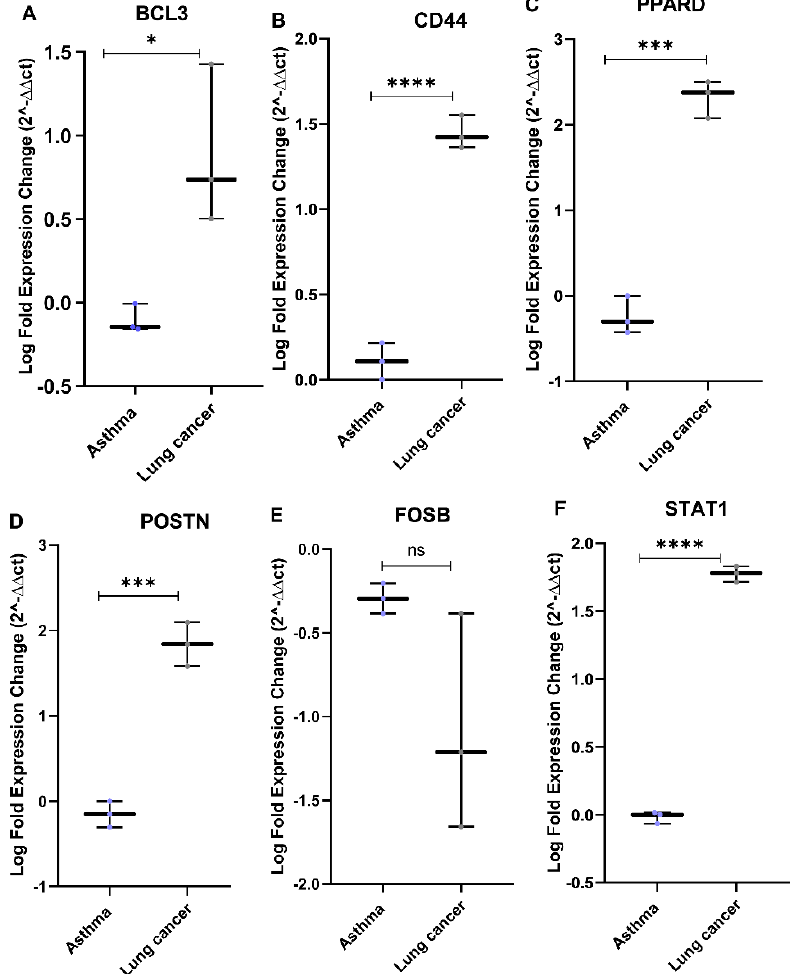
Figure 9. Boxplots for the differential expression of genes identified in silico in plasma samples collected from asthmatics and lung cancer patients. ( A ) BCL3 , ( B ) CD44 , ( C ) PPARD , ( D ) POSTN , ( E ) FOSB , and ( F ) STAT1 (Mann − Whitney test, significance * p < 0.05, *** p < 0.001, **** p < 0.0001, ns — not significant).